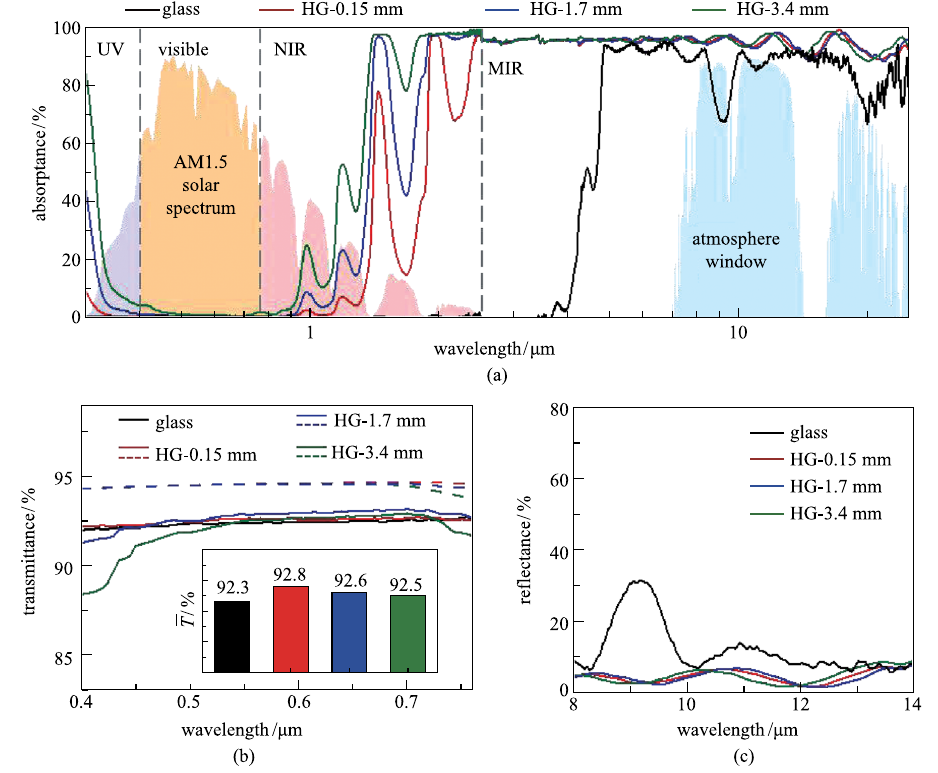
Fig. 2 Spectral characteristics of the hydrogel-glass with different-thickness hydrogel layers compared with traditional glass. a Measured spectral absorptance in the wavelength range from 0.3 to 25 μm. Here, HG in the figure is abbreviation of hydrogel-glass. b Spectral transmit- tance in visible light. The solid and dashed lines represent the measured and calculated results, respectively. The inset chart shows the average T transmittance ( ). c Measured spectral reflectance in the wavelengths of infrared transparency window of